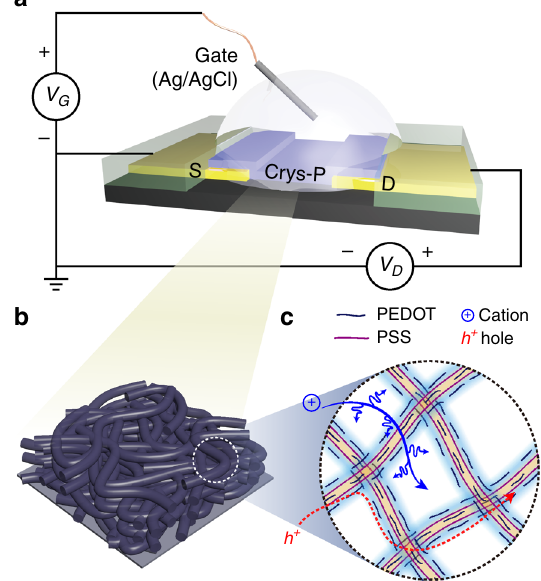
Fig. 1 Crystallized PEDOT:PSS (Crys-P) OECTs. a An illustration of the device con fi guration of Crys-P OECT. b A schematic diagram of the Crys-P fi lm microstructure and c the hole and ion transport